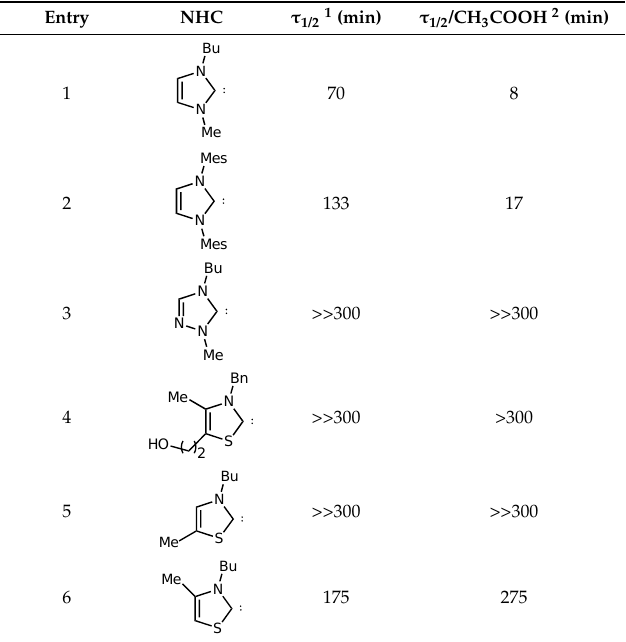
Table 1. τ 1/2 Values for NHCs in the absence and in the presence of acetic acid. Reproduced with permission from [32]. Copyright Wiley-VCH, 2016.